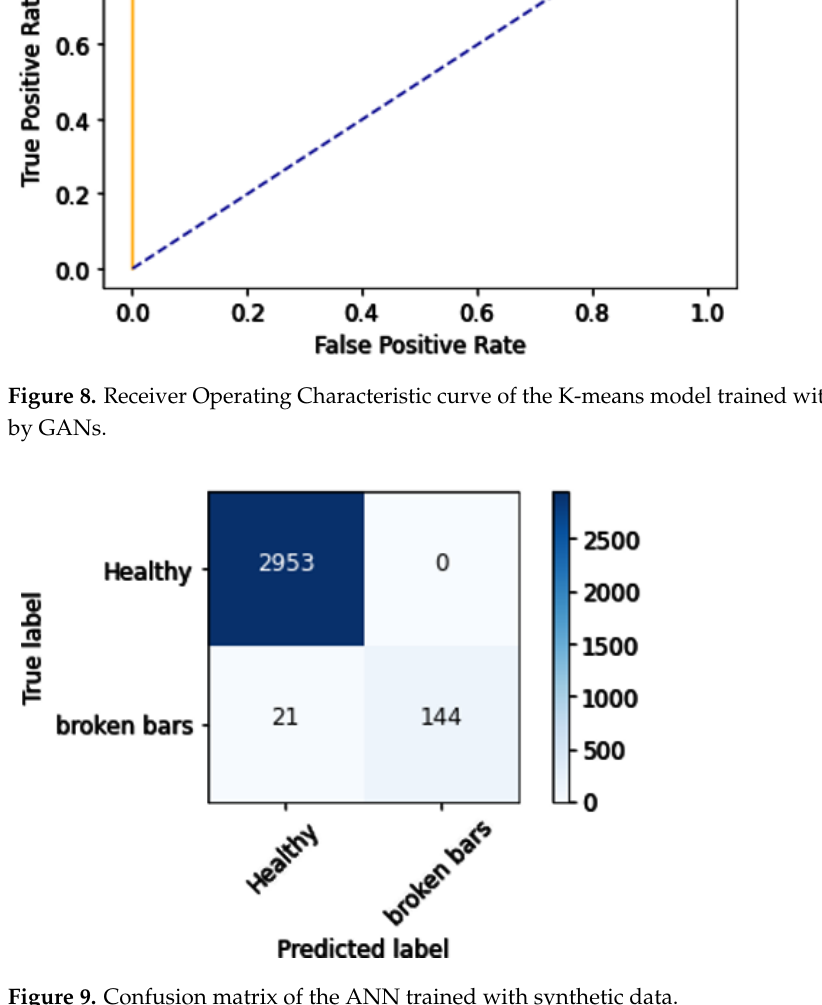
Figure 9. Confusion matrix of the ANN trained with synthetic data.